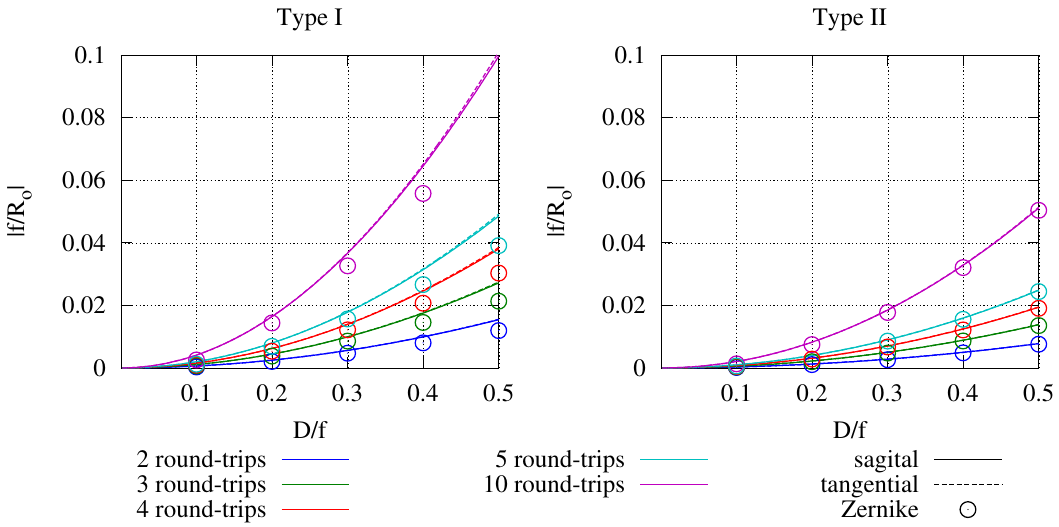
Figure 8. Absolute astigmatic deformation of the wavefront as a function of the ratio between the diameter D of optic L 1 and its focal width f for Type I and Type II systems. Lines are calculated by the matrix method, and single data points originate from FRED ray tracings.